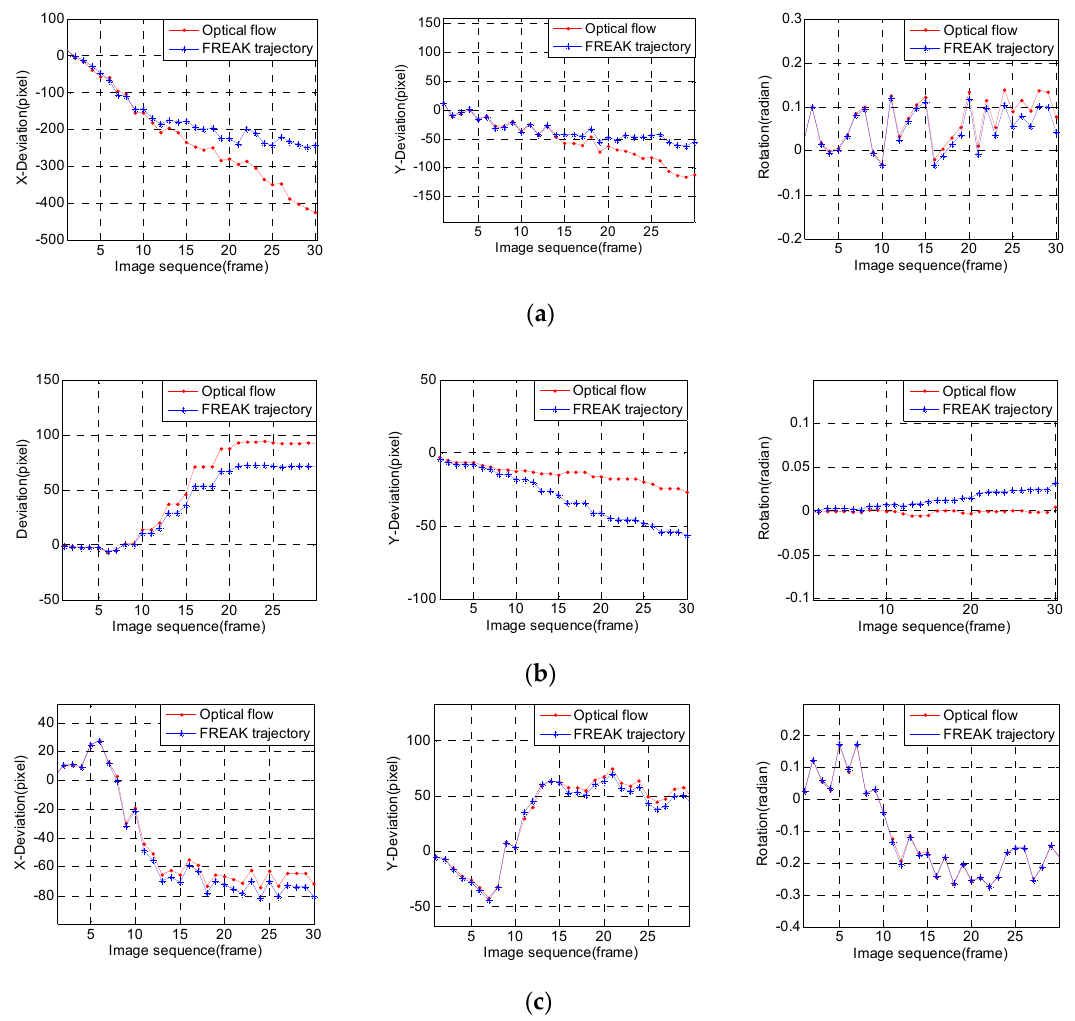
Figure 6. Comparison of the trajectories obtained by optical flow and FREAK (Fast Retina Keypoint) algorithm with different image sequences. ( a ) Image sequence of moving vehicle; ( b ) Image sequence of unmanned aircraft; ( c ) Image sequence of missile.